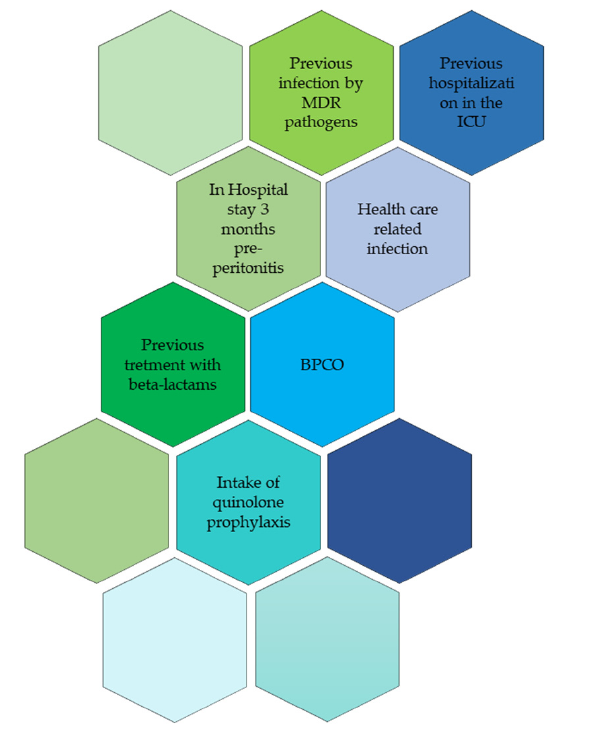
Figure 5. Graphic synthesis of the predictive factors of MDR-driven peritonitis.